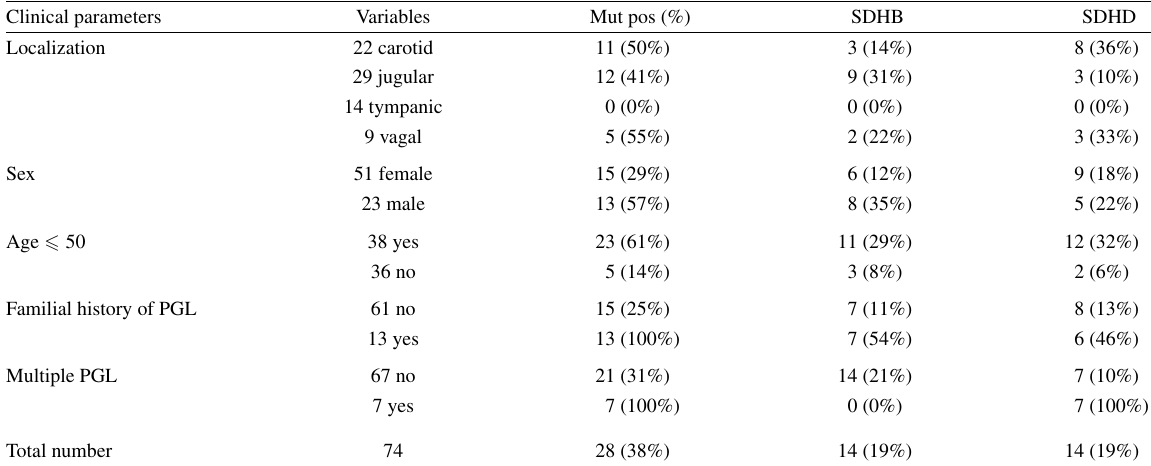
Clinical features related to germline SDH